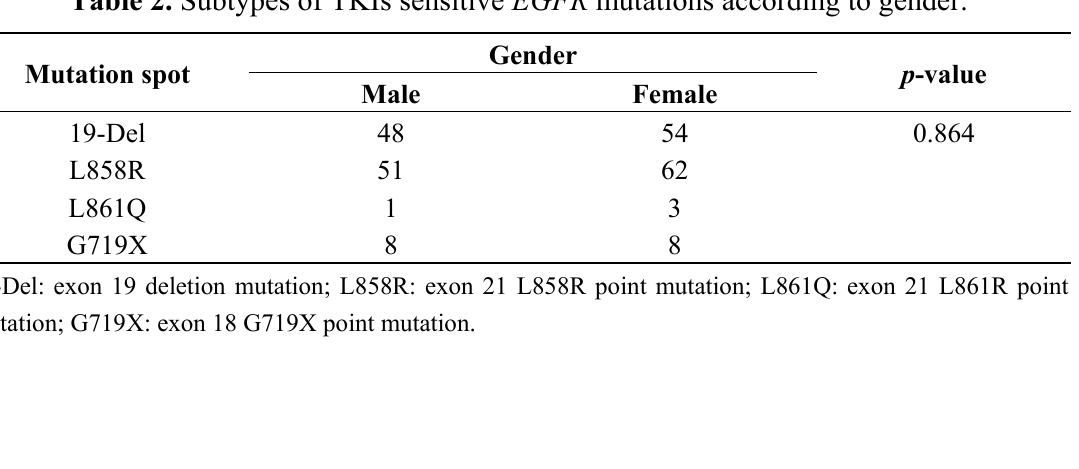
Table 2. Subtypes of TKIs sensitive EGFR mutations according to